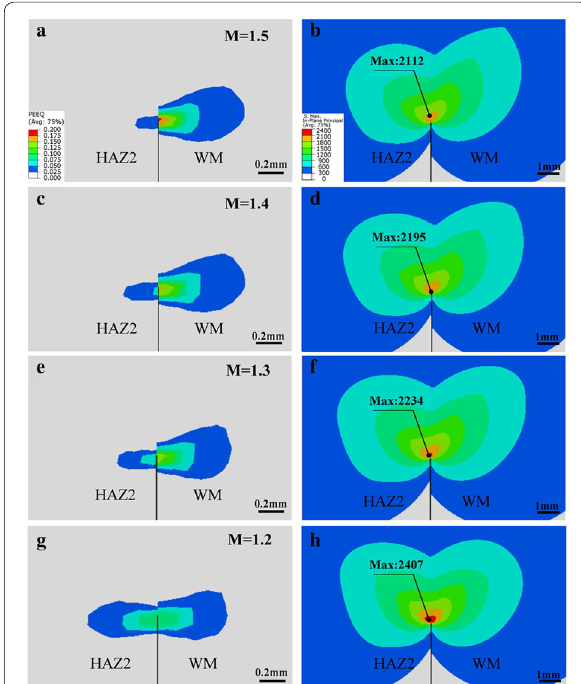
Figure 6 Distributions of strain and stress around crack tip at the interface between HAZ2/WM: a , c , e , g Equivalent plastic strain (PEEQ); b , d , f , h Maximum principal stress ( S , max) (Unit in b , d , f , h